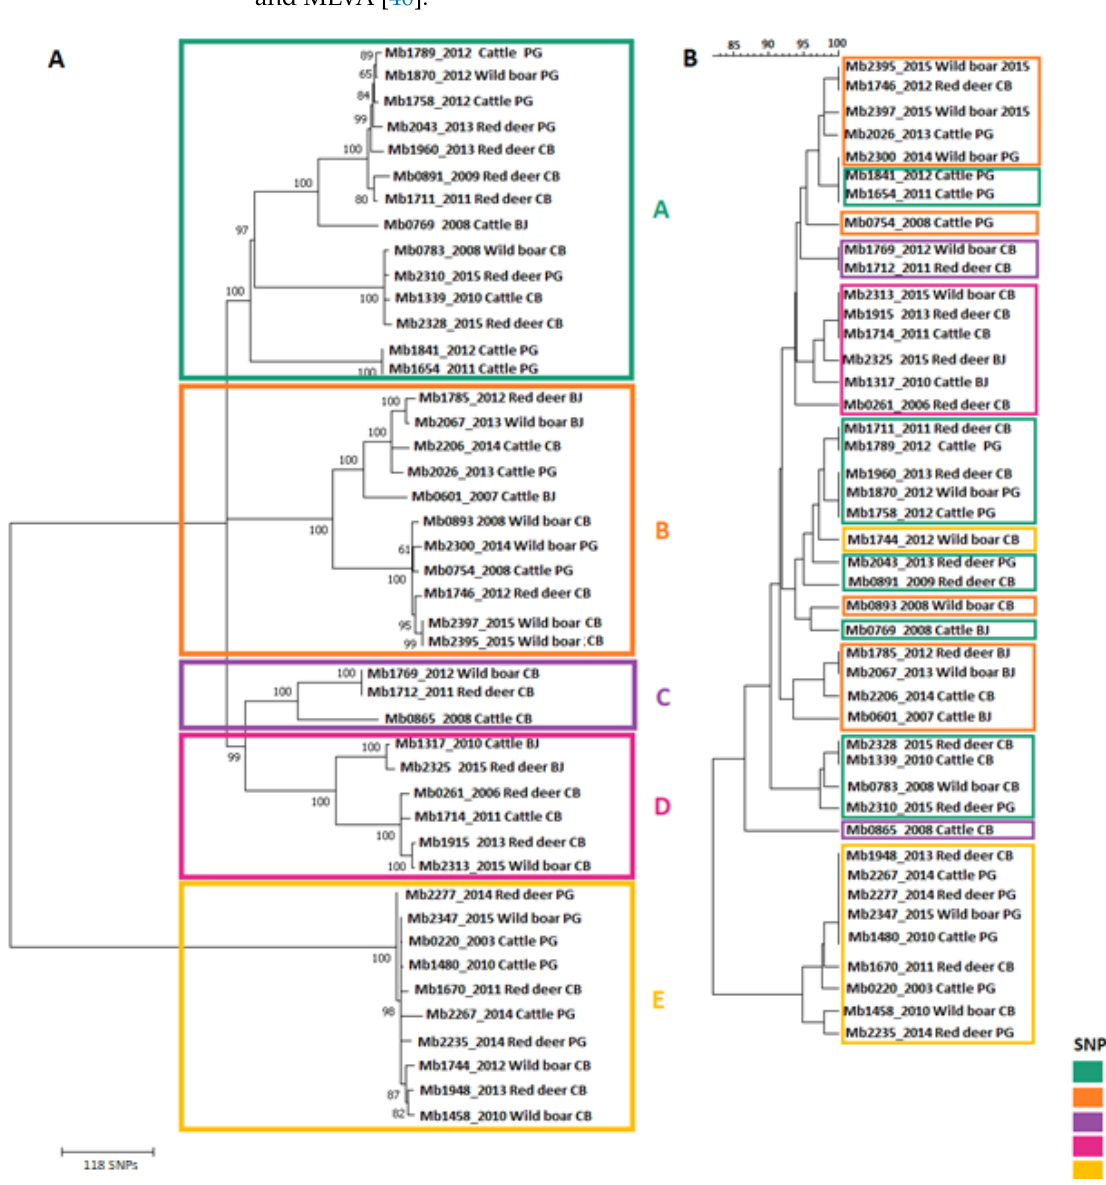
Figure 1. Genetic relatedness of M. bovis field strains from TB hotspots in Portugal. ( A ) Maximum Likelihood Tree using GTR model with input taken as an alignment file containing only informative and validated SNPs. The tree is drawn to SNP scale. The bootstrap values are represented. ( B ) UPGMA tree, applying categorical option as a similarity coefficient, with input taken as the combined dataset based on spoligotyping and 8- loci MIRU-VNTR data. Colors identify the different SNP clades (A—dark cyan, B—orange, C—purple, D—pink and E—yellow).